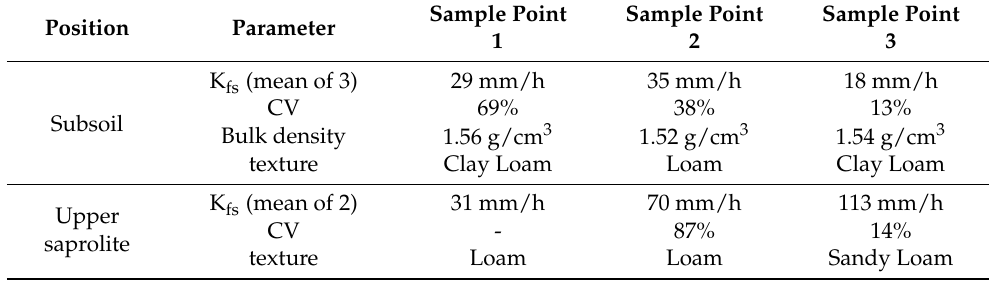
Table 1. Field saturated conductivity (K fs ), coefficient of variation, and soil properties of the sub-soil and the upper saprolite at the mid-slope position of each plot (point 1: crop production; Figure 3. Resistivity tomography with topography at a transect stretching from the wetland to the point 2: semi-natural vegetation; point 3: bare fallow). hilltop (500 m profile length), unit electrode spacing 2.5 m.